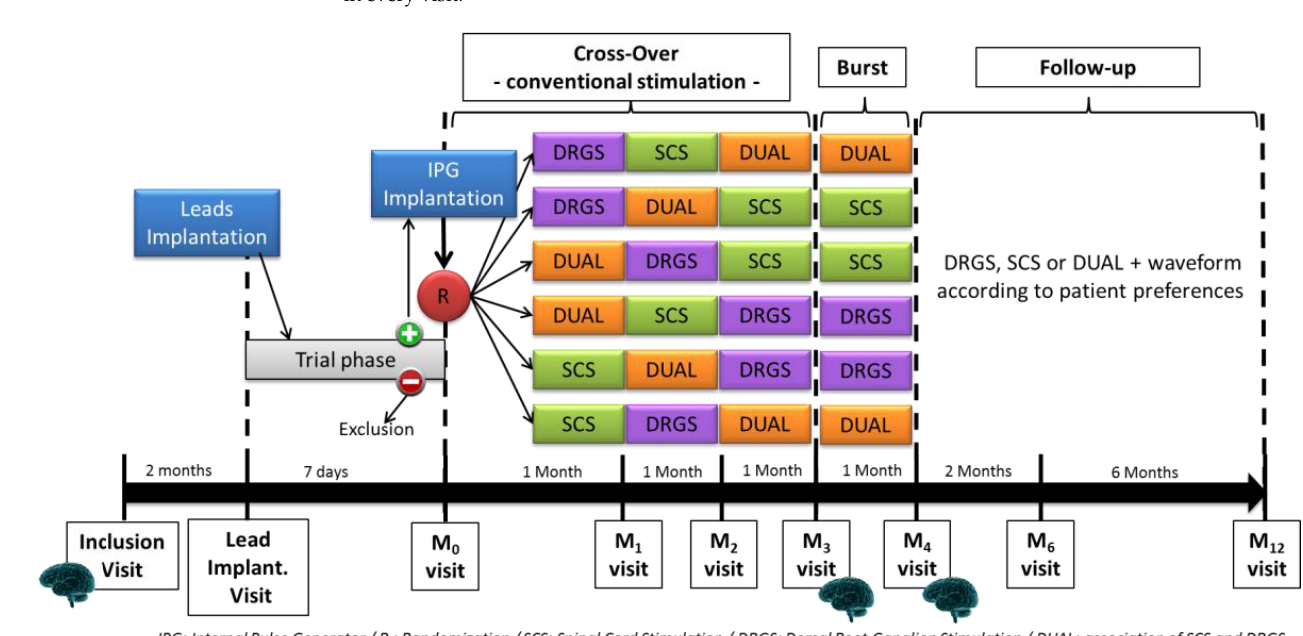
Figure 1. BOOST DRG study design (applicable for phase A and phase B).